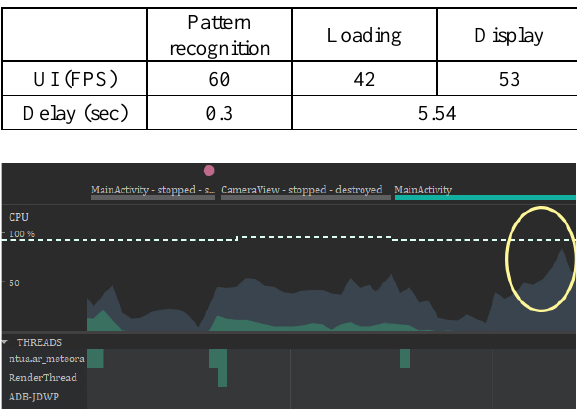
Figure 8 . Graph of real-time CPU usage while the user captures the pattern image (CameraView activity) and enables the AR functionality (MainActivity activity). The increased CPU usage at the moment of pattern recognition is